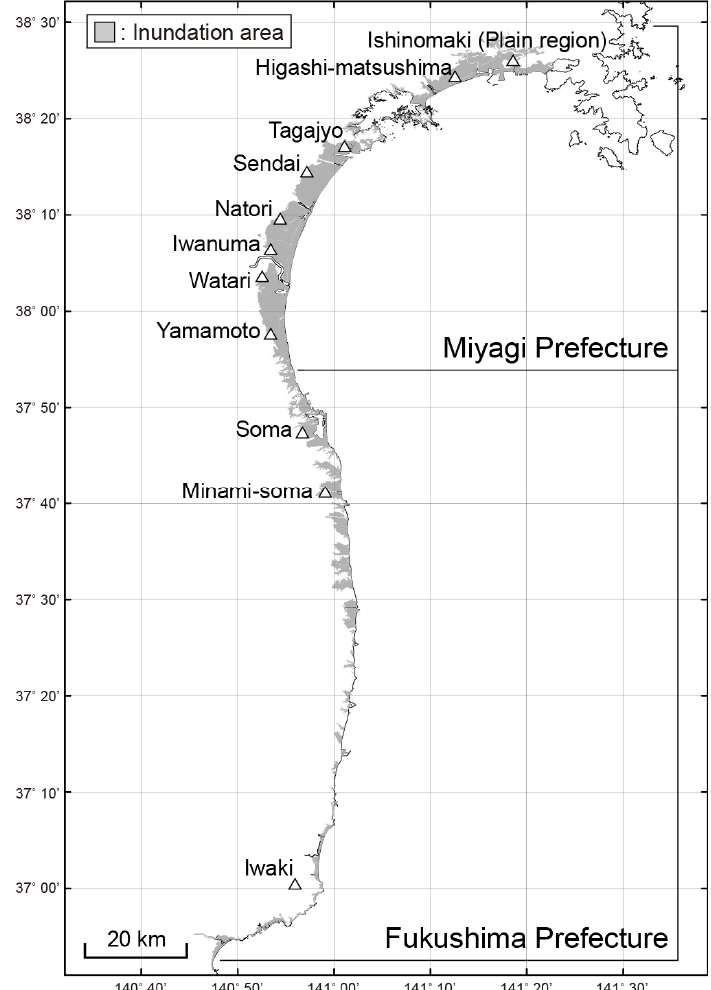
Figure 10. Analysis area used for constructing the fragility function. The triangular symbol indicates the approximate center position of local municipality analyzed.